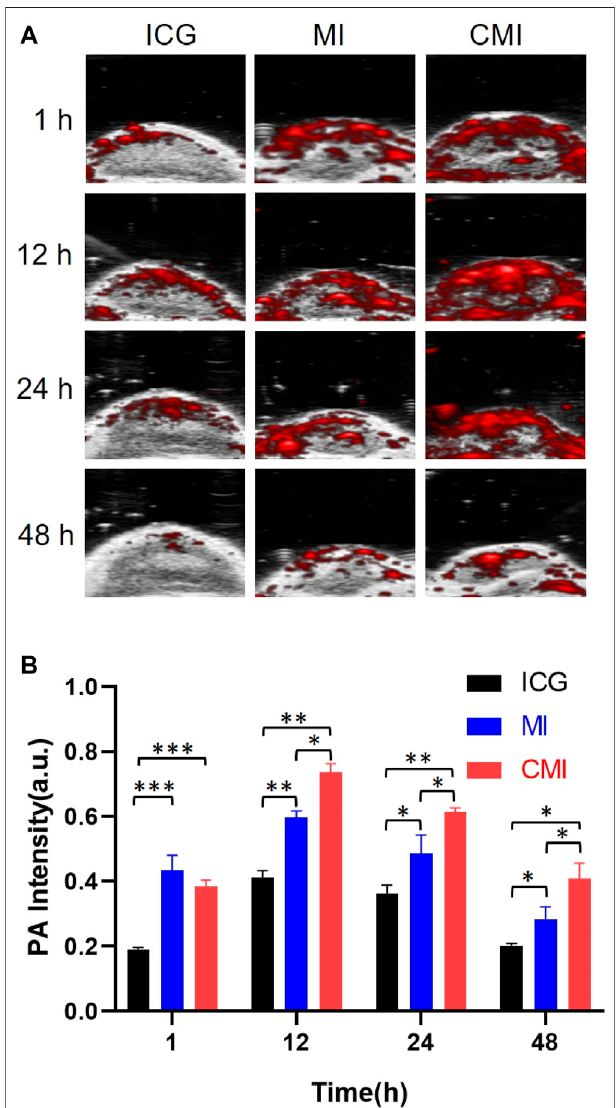
FIGURE 5 | In vivo PA imaging of Hela tumor-bearing nude mice. (A) PA images of the tumor region after intravenous tail injection of ICG formulations (10mg/kgICG)atdifferenttimepoints. (B) Fluorescentsignalmeasurementof ICGformulationsinthetumorregionatdifferenttimepoints.ICG,MI,and CMI (containing an ICG dose of 10 mg/kg) were injected into the Hela tumor- bearing nude mice through the tail vein ( n (cid:2) 3/group). At 1, 12, 24, and 48 h after injection, the fl uorescent signals were measured by using the Step and Shoot modes with 100 angles and 15 pulses per angle in the V evo LAZR-X multimode imaging system. The results were processed by V evo LAB 3.2.0 software (* < 0.05; ** < 0.01; *** < 0.001.)